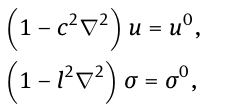
(cid:113) where r 1 = ( x − x 0 ) 2 + y 2 , r 2 = picted in Fig. 1 and γ is defined by